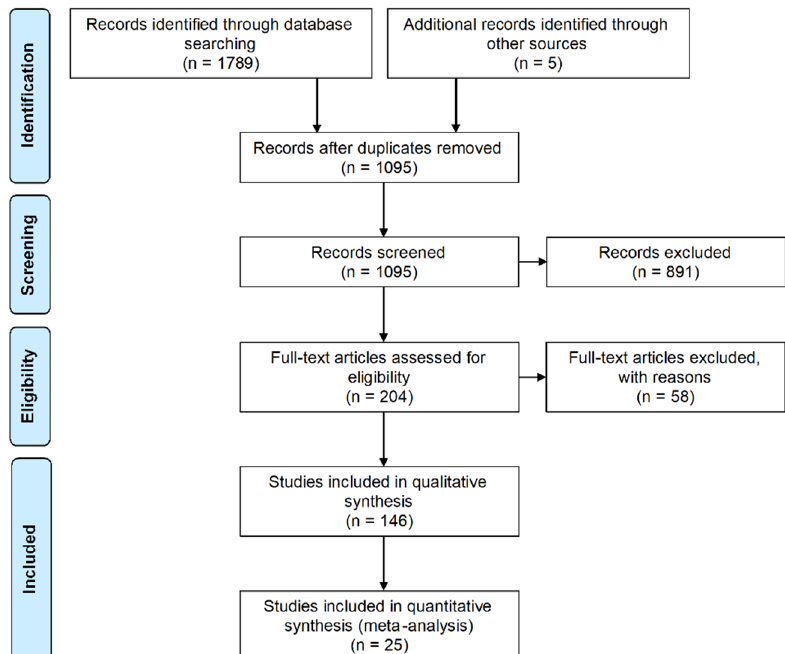
Figure 1. PRISMA flow diagram. Flowchart of systematic literature search according to PRISMA guidelines. Modified from: Moher D, Liberati A, Tetzlaff J, Altman DG, The PRISMA Group (2009). Preferred Reporting Items for Systematic Reviews and Meta-Analyses: The PRISMA Statement. PLoS Med 6 (7): e1000097 [52].